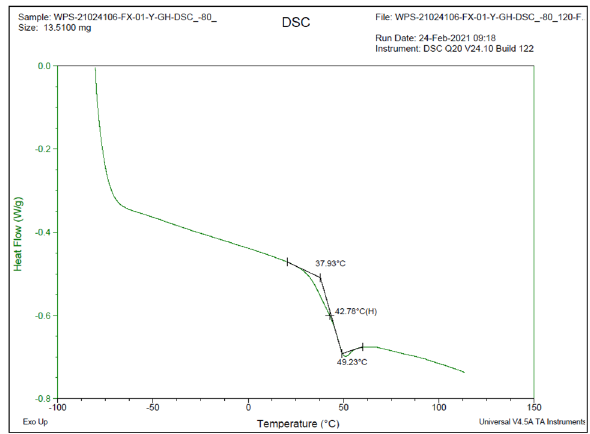
Figure 2. Differential scanning calorimetry (DSC) analysis results.